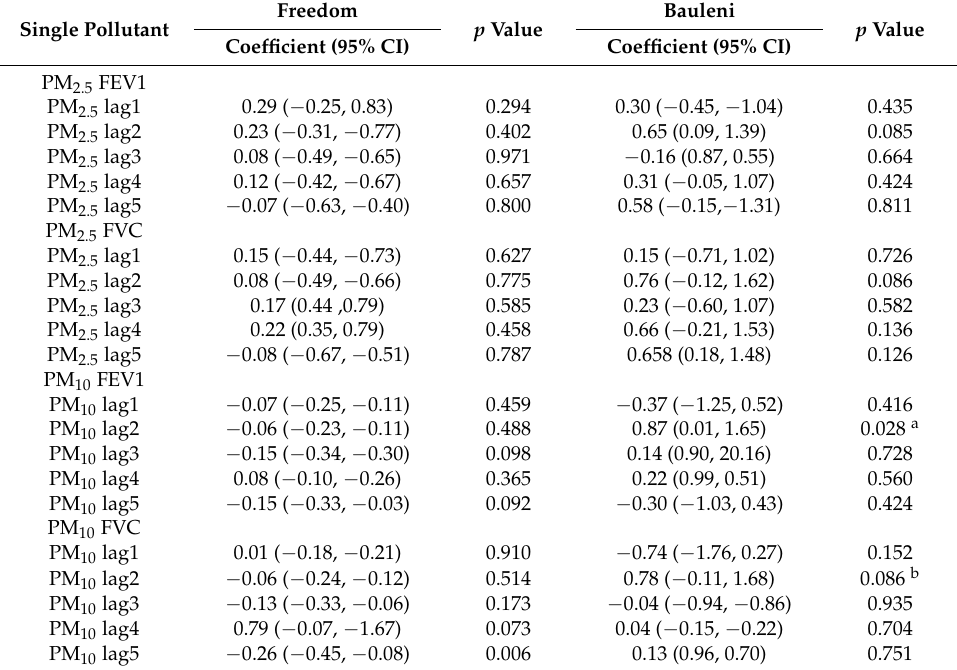
Table 6. Adjusted estimates of associations between PM concentrations and lung